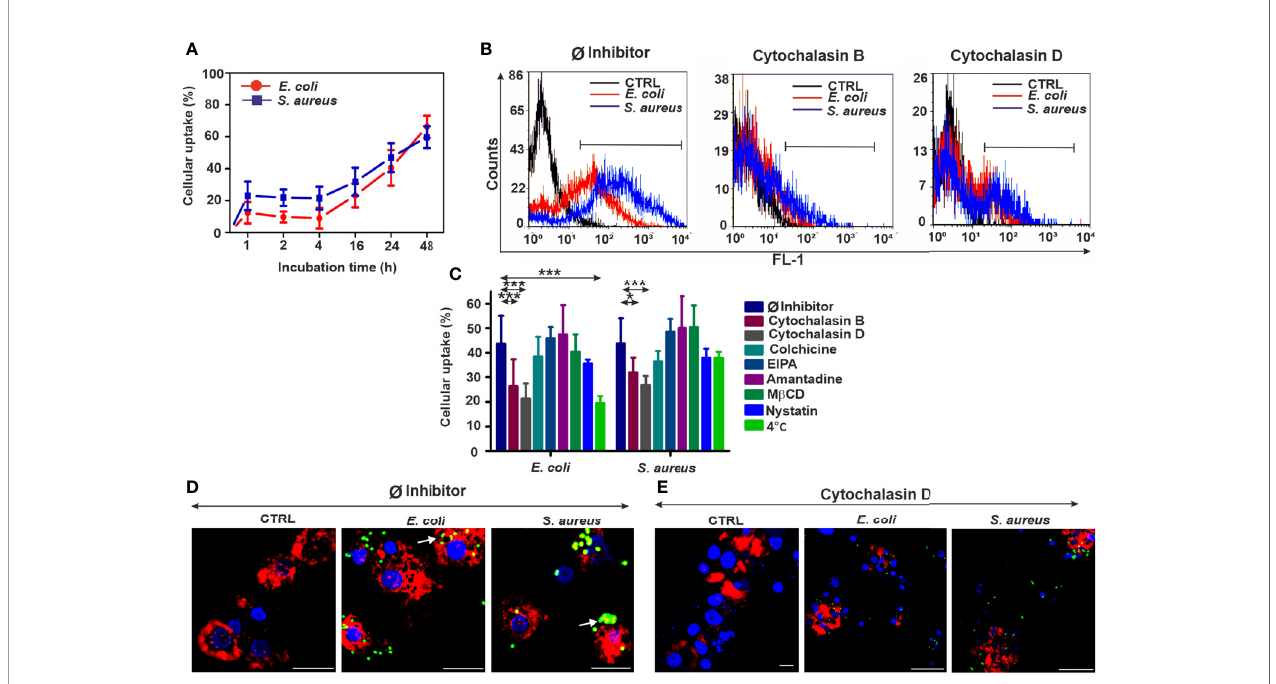
FIGURE 3 | Reduced bacterial uptake in the coelomocytes following endocytosis inhibition. (A) Uptake kinetics of FITC- E. coli and FITC- S. aureus bacteria by coelomocytes after 1, 2, 4, 16, 24, and 48 h of incubation. (B) Representative fl ow cytometry histograms after 24 h of bacteria engulfment without or with inhibitors (5 µM cytochalasin B/cytochalasin D). (C) Ef fi ciency of numerous endocytosis inhibitors on the bacterial uptake in coelomocytes. The results are exhibited as mean ± SD of four replicates. Asterisks indicate statistical signi fi cance (* p < 0.05, *** p < 0.001) between the Ø inhibitor control and different treatments. (D) Merged CLSM images of coelomocytes in the absence or (E) presence of 5 µM cytochalasin D that display the changes in the actin cytoskeleton (red: CF568 Phalloidin) and inhibition of bacterial (green, FITC- E. coli and FITC- S. aureus ) uptake. Nuclear counterstaining was performed with DAPI (blue). Note the overlapping signal between engulfed bacteria and actin fi laments (arrows, D ). Scale bars: 20